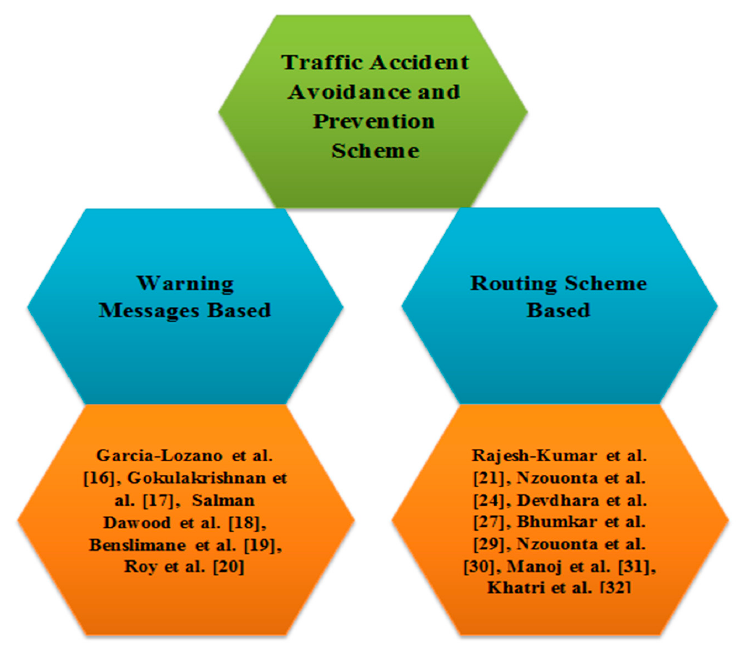
Figure 1. Taxonomy of Literature Review.